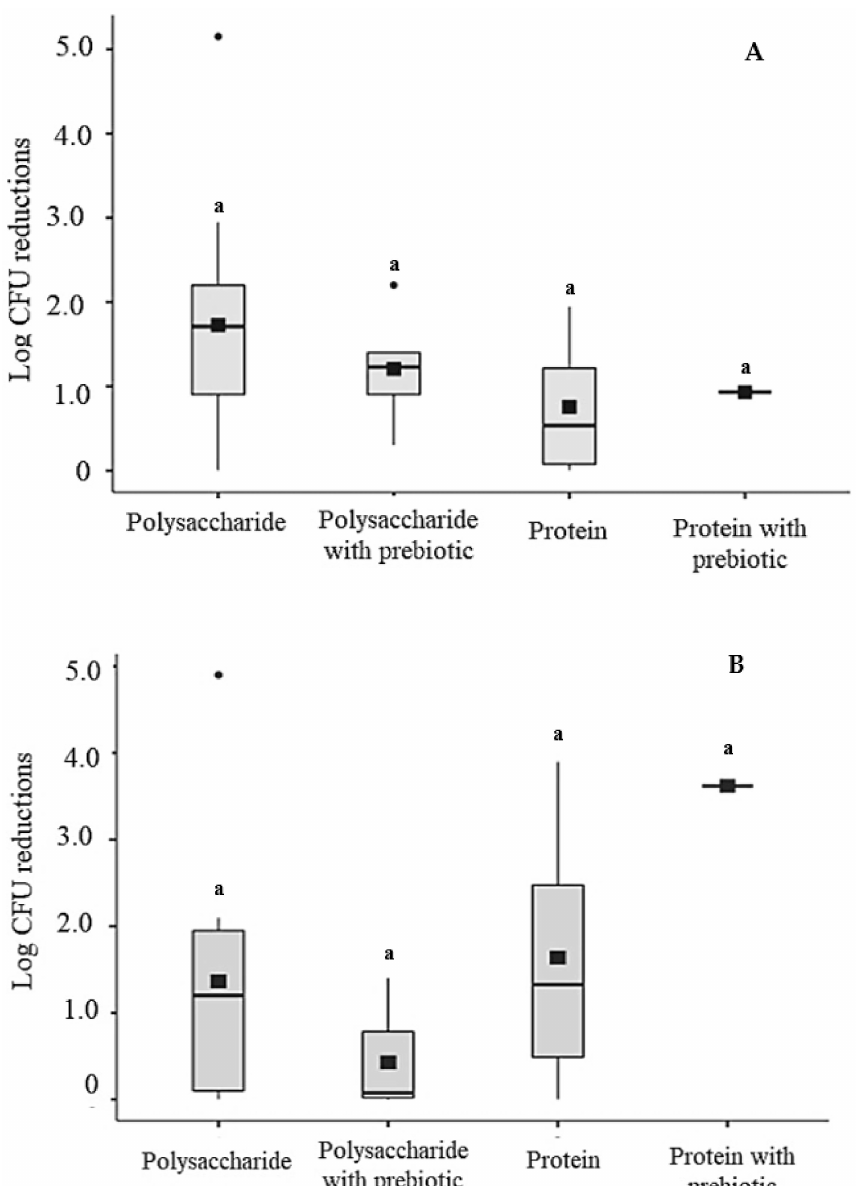
Figure 1. Assumed average variation ( ± standard deviation) of the reduction in initial viable counts of probiotics loaded into edible films/coatings. Columns with the same letters did not differ significantly ( p > 0.05) based on Kruskal–Wallis test. Relative log CFU reduction is the difference between the population of probiotics loaded into films/coatings before and after (day zero or 1) application to fruit and vegetables ( A ) and at the end (last day) of the measured storage period ( B